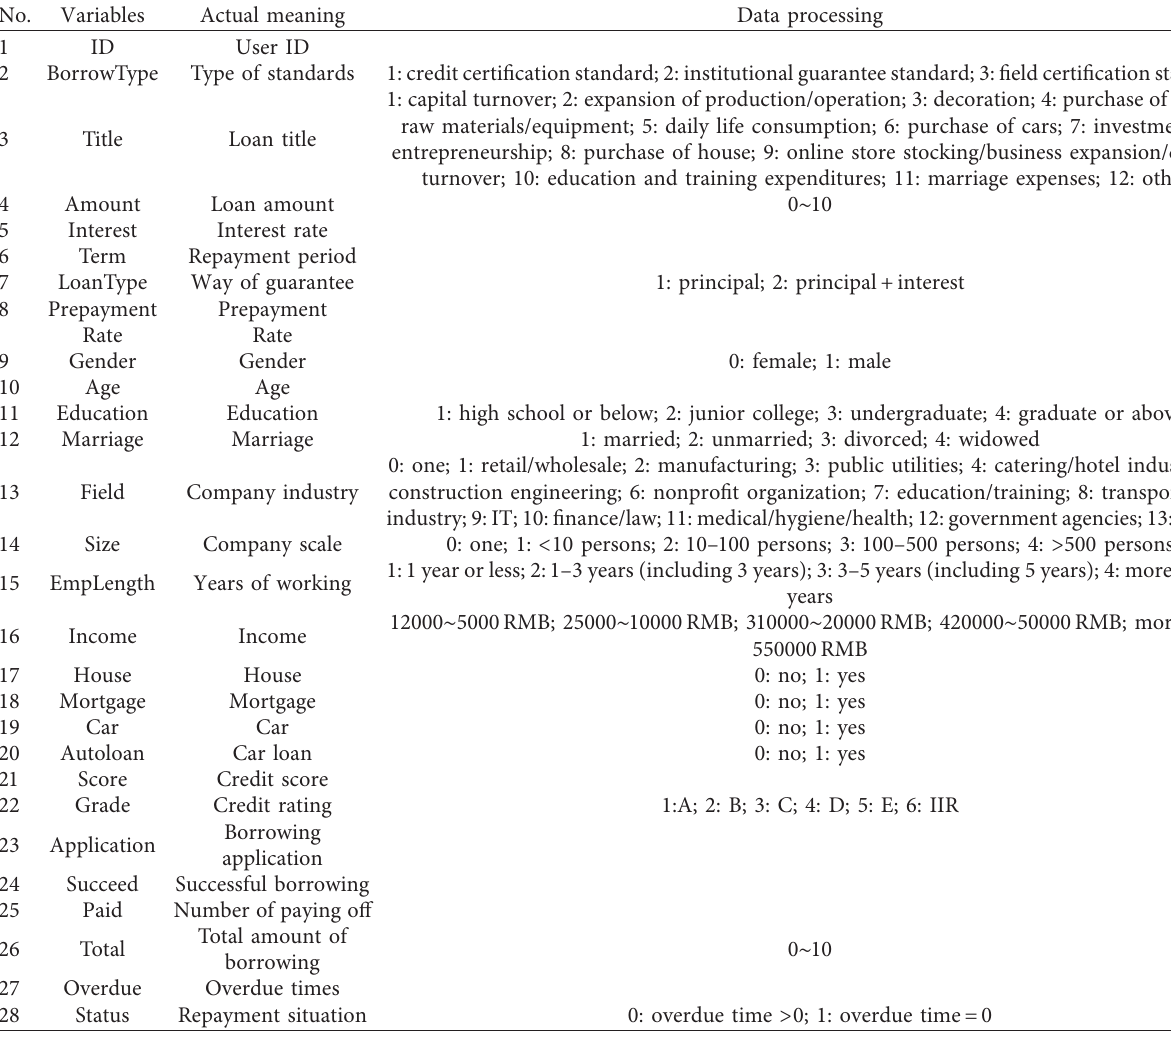
Table 1: Basic information of